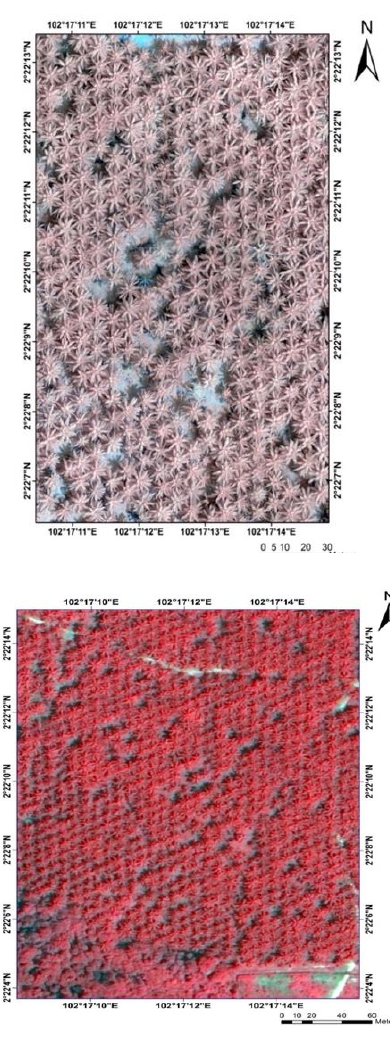
Figure 1. The UAV CIR image of the study area (top) and the Pleiades image